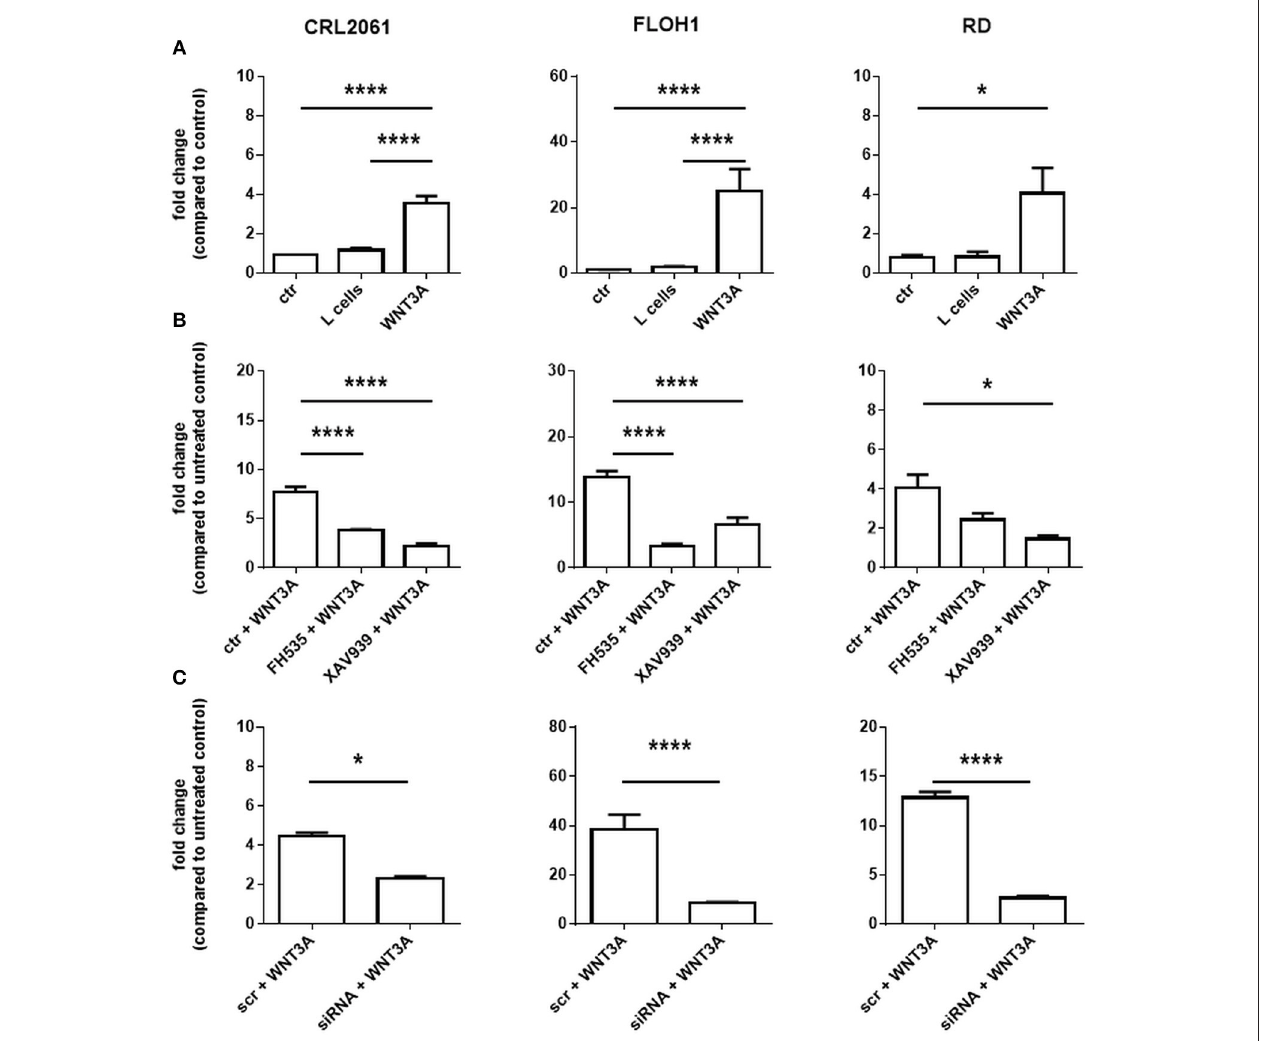
FIGURE 2 | Effects of FH535, XAV939, ß-catenin siRNA, and/or WNT3A on the expression level of the ß-catenin target gene AXIN2 in RMS cell lines. (A) AXIN2 -specific qRT-PCR without or after 24h of pretreatment with FH535, XAV939 (B) or ß-catenin specific siRNA (C) . Please not that the batches of WNT3A conditioned medium were not identical. GAPDH expression was used for normalization. Shown is the mean and SEM of three independent experiments measured in duplicates; ctr, control; scr, scrambled RNA; significance level: * p < 0.05, **** p <